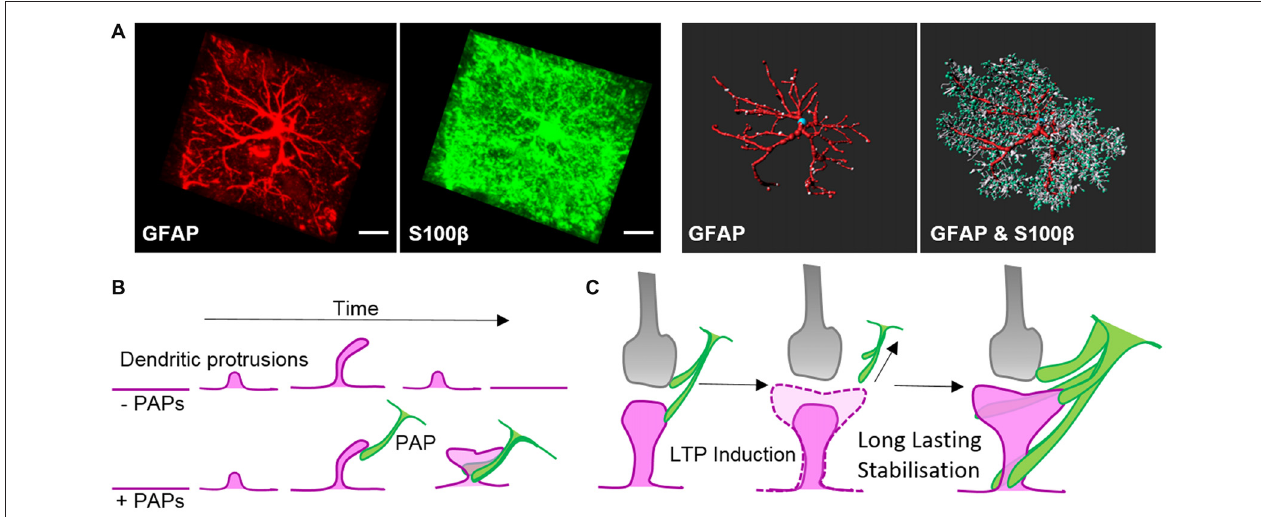
FIGURE 2 | Morphology of astrocytes in vivo and their dynamic association with synapses. (A) Z -projection of a cortical rat astrocyte (P14), stained for glial fibrillary acidic protein (GFAP; red) and S100 β (green), by confocal microscopy after tissue clearance (left). Scale bars: 10 µ m. 3D rendering and morphometric analyses show the restriction of the intermediate filament protein GFAP to main processes, which are decorated with myriads of fine S100 β -positive processes (right; with permission from Murk et al., 2013). (B) Schematic of dendritic filopodia, with the precursors of dendritic spines, emerging from dendrites (magenta) in the absence (top) or presence of perisynaptic astrocytic processes (PAPs; green, bottom). Without the support of astrocytic processes, sprouting dendritic filopodia have a short lifespan and are likely to retract. Astrocytic processes contact filopodia-like protrusions, which then exhibit an increased stability and higher tendency to develop into mature dendritic spines. (C) Schematic of a mature tripartite synapse consisting of the pre-synapse (gray), post-synapse (magenta) and PAPs (green), which respond to long-term potentiation (LTP) with structural changes. Induction of LTP transiently enhances the motility and retraction of PAPs allowing growth of the postsynaptic dendritic spine to occur. Subsequent to dendritic spine remodeling, PAPs intensify their coverage of synapses.